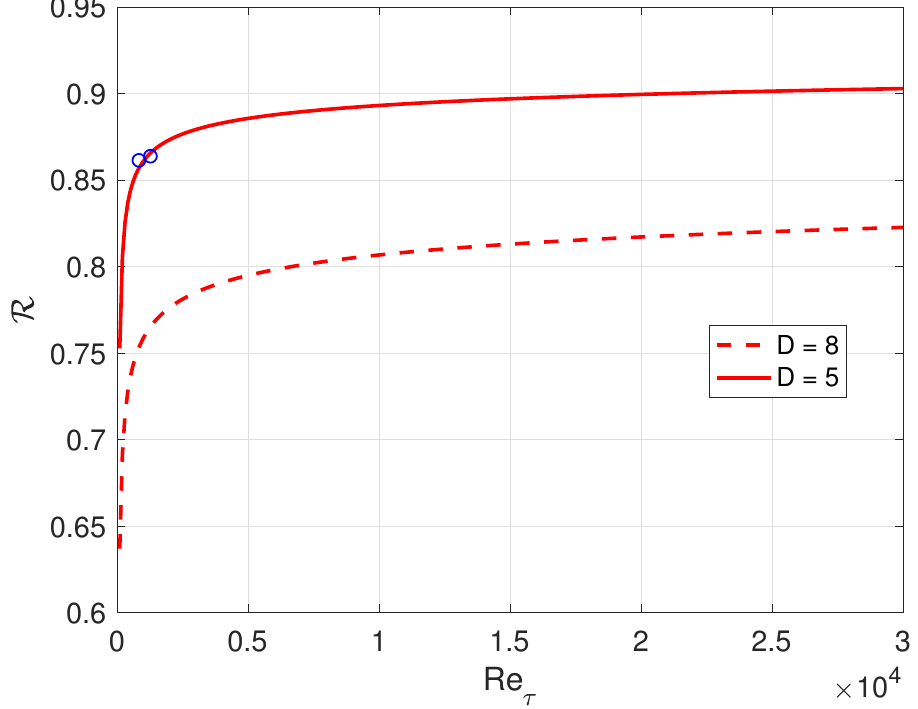
(Equation (15)) as a function of Re τ . The blue circles mark the ratios Figure 6. The predicted ratio R from the two non-rotating BBL